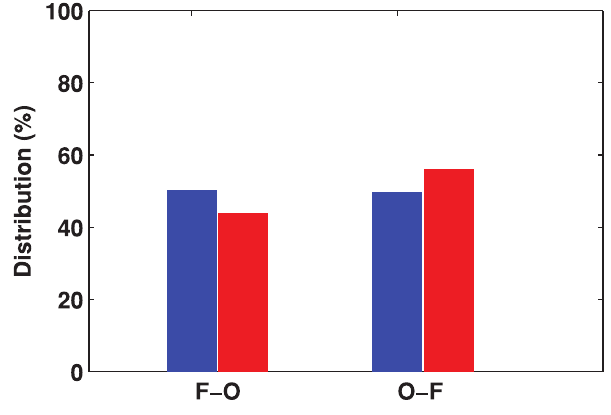
Figure 6. Distribution of alpha waves between the two directions (frontal-to-occipital direction and occipital-to-fron- tal direction) before and after stimulus onset. The blue bars indicate the prestimulus waves measured in the 500 ms interval before stimulus onset and the red bars indicate the poststimulus waves measured in the 500 ms interval after stimulus